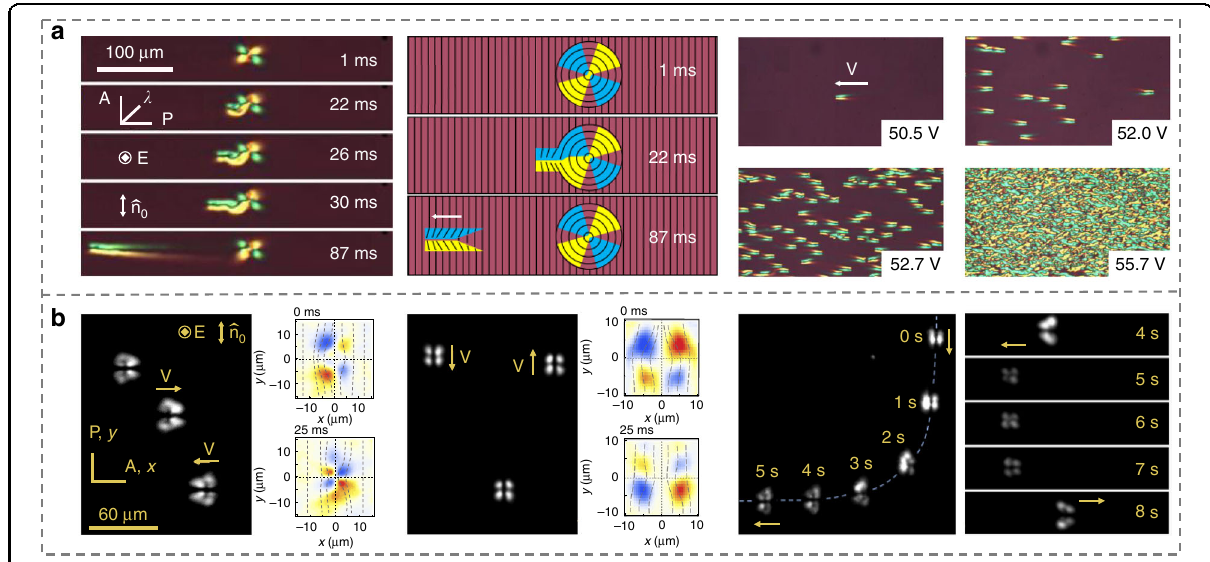
Fig. 3 Controls of dynamic architectures in NLCs. a Electrical generation of 3D NLC director bullets 78 . Adapted from ref. 78 , with permission from Springer Nature: Nature Communications. b Dynamic steering of LC solitons 79 . Adapted from ref. 79 , with permission from Springer Nature: Nature